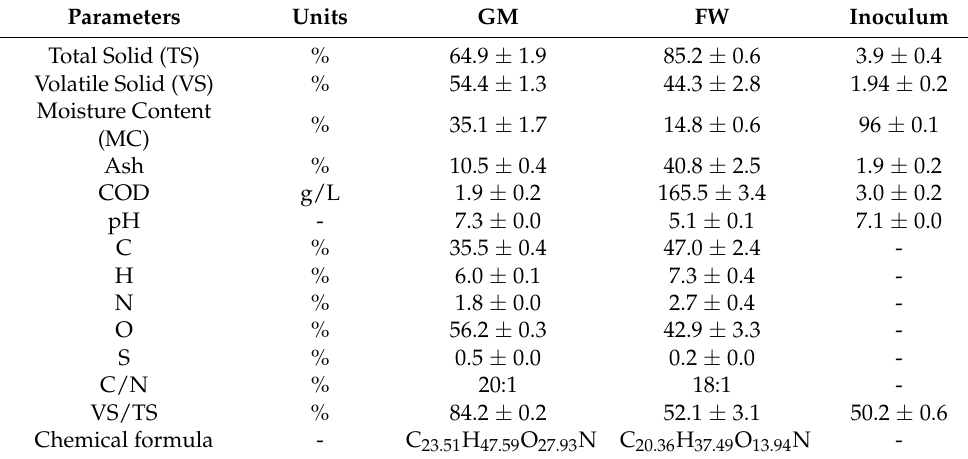
Table 1. Characteristics of goat manure (GM), food waste (FW), and inoculum.